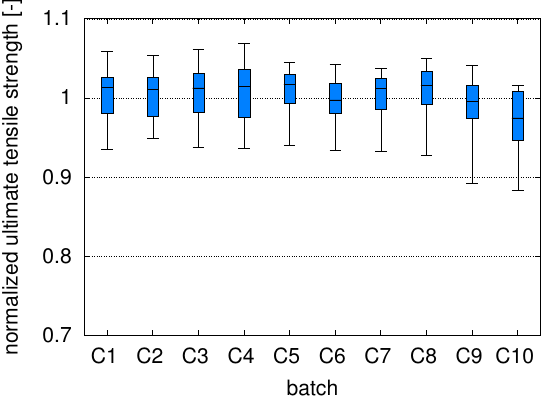
Figure 11. Distribution of the normalized stress with respect to the mean ultimate tensile strength ( R m ) in A50 samples